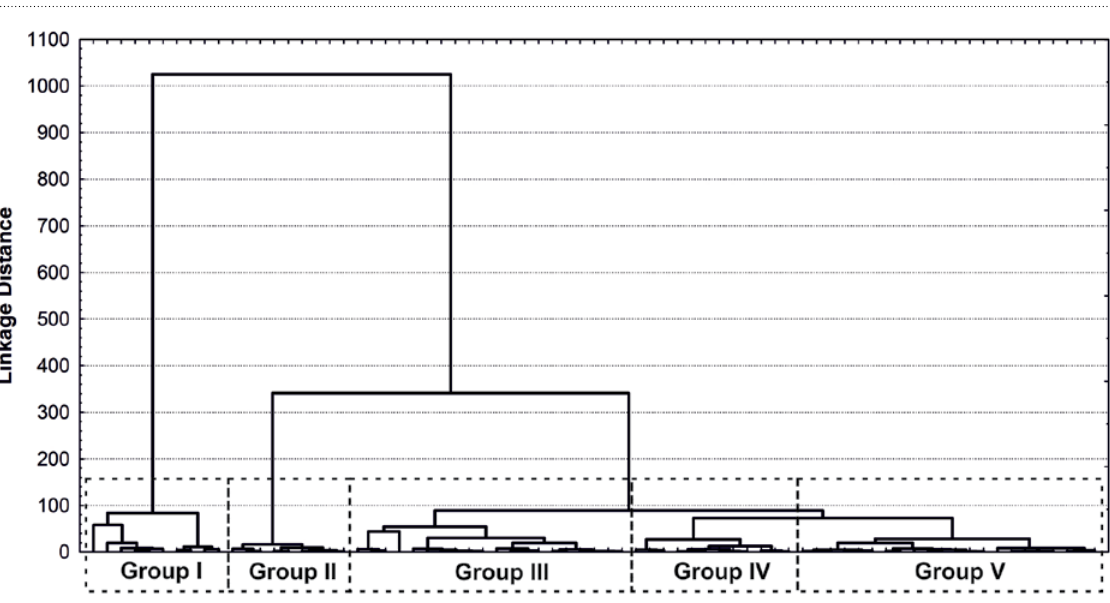
Figure 3. Dendrogram of cluster analysis of herbal infusions with relation to metals